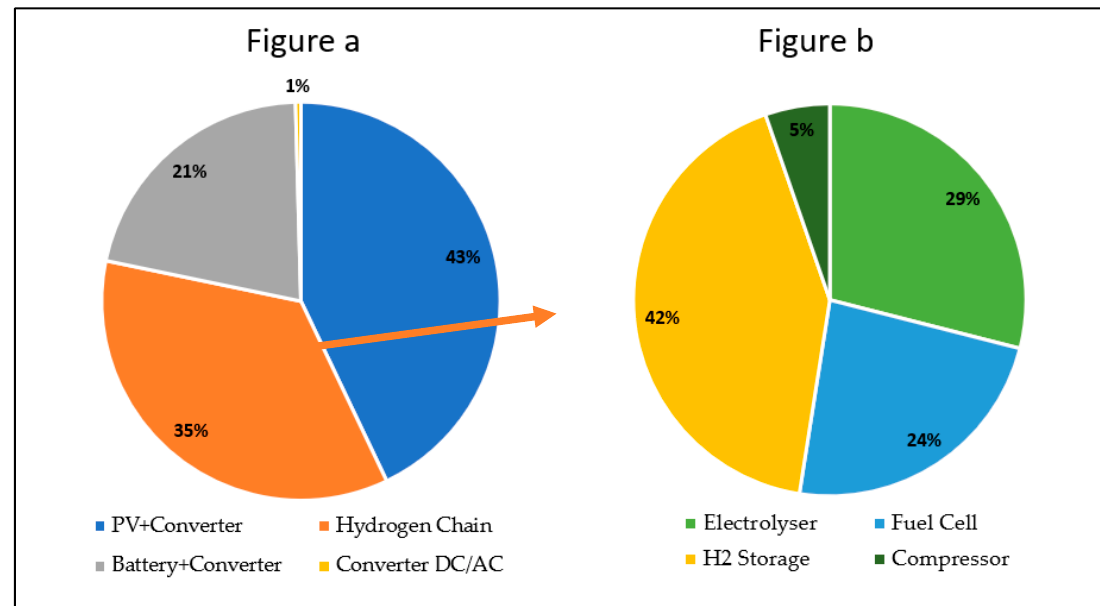
Figure 7. ( a ) Cost structure for 20 years of operation of the overall system; ( b ) cost structure of the hydrogen chain.